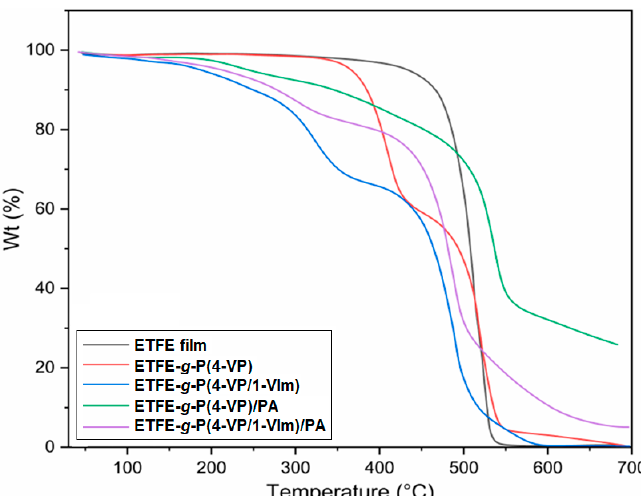
Figure 10. TGA thermograms of pristine ETFE film, ETFE- g -P(4-VP), and ETFE- g -P(4-VP/1-VIm) films compared to ETFE- g -P(4-VP)/PA and ETFE- g -P(4-VP/1-VIm)/PA membranes. Table 1. TGA data of various degradation of pristine ETFE film, ETFE- g -P(4-VP), and ETFE- g -P(4- VP/1-VIm) films compared to ETFE- g -P(4-VP)/PA and ETFE- g -P(4-VP/1-VIm)/PA membranes.